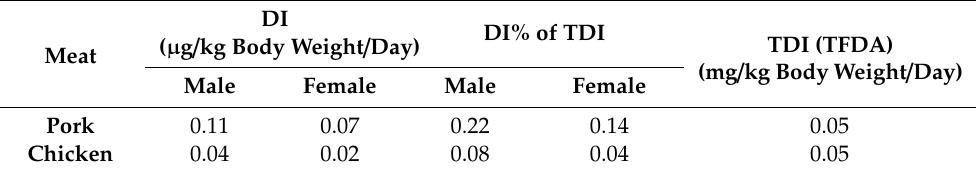
Table 4. Estimated daily intake (DI) levels of DEHP residues in meat and their percentage of tolerable daily intake (TDI) level in Taiwanese